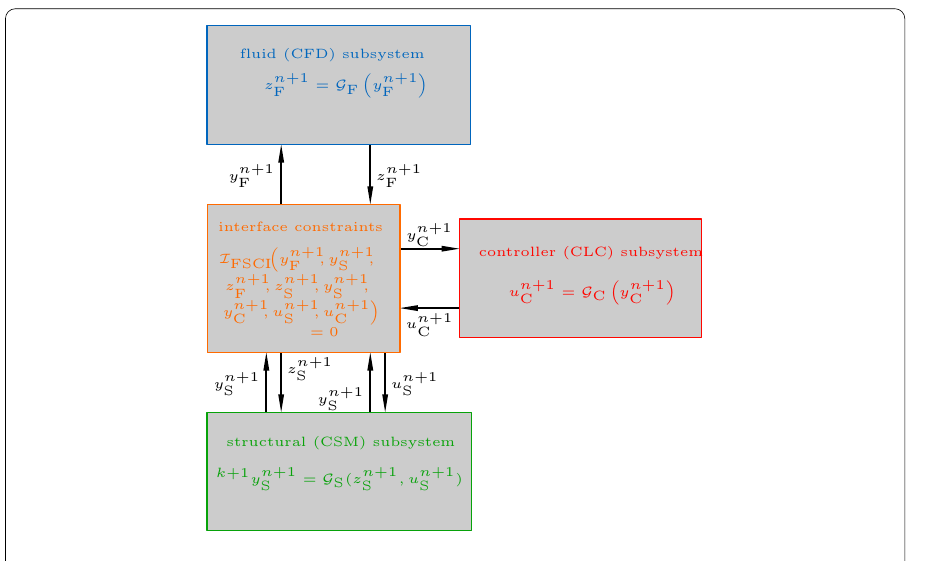
Fig. 2 Block diagram for FSCI